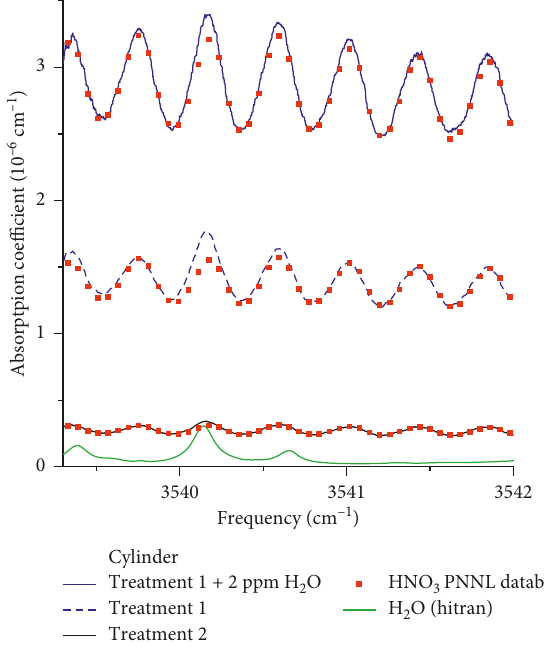
Figure 6: Measurement of HNO 3 in 3 different 10 µ mol/mol NO 2 standards. The PNNL spectra for HNO 3 are shown together with a water absorption spectrum from HITRAN. The highest observed Figure 5: Measurement of CO 2 in high purity nitrogen using HNO 3 amount fraction is 456nmol/mol for cylinder treatment 1 different kinds of tubings. The flow rate is 30 L/h. The observed with 2 µ mol/mol H 2 O added. The lowest observed HNO 3 amount CO 2 amount fractions are 2 nmol/mol for 2 m long stainless fraction (treatment 2) is steel ( ) tubing, 85nmol/mol for 10m long PTFE ( ), 14nmol/mol for the ca 1.2m long FEP ( ), and 5nmol/mol for the ca 0.6m long FEP ( ).